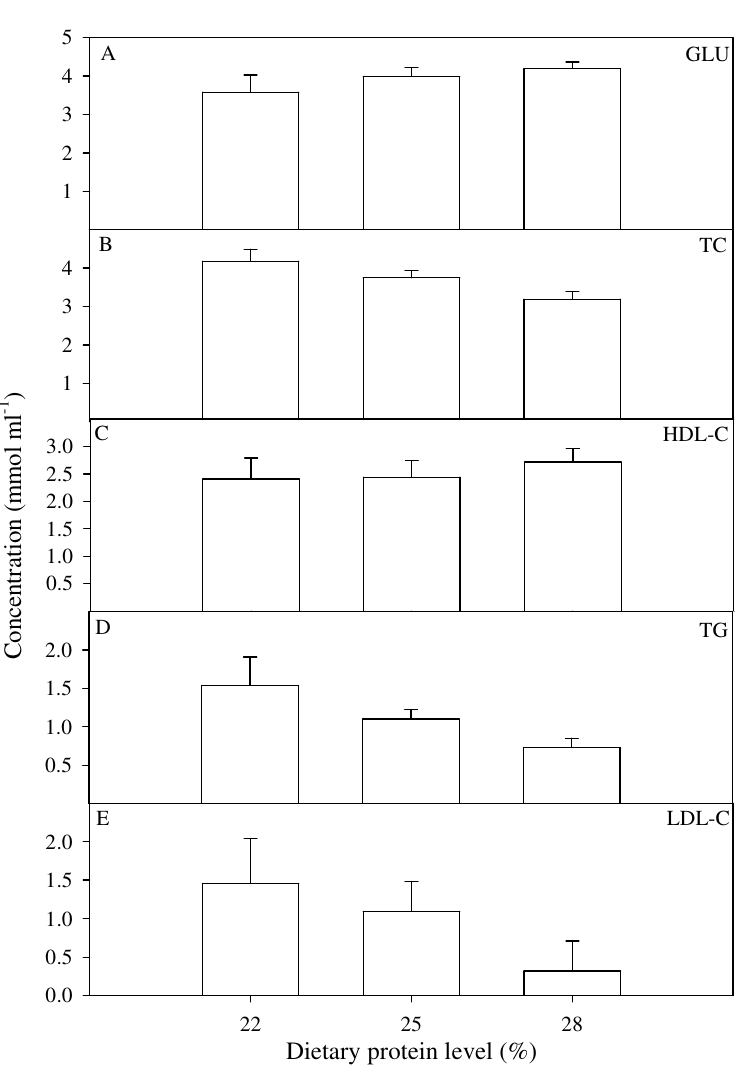
FIGURE 1. Effects of dietary protein levels on (A) GLU, (B) TC, (C) HDL-C, (D) TG, and (E) LDL-C of the new GIFT strain of juvenile Nile tilapia. Error bars represent one standard deviation of each